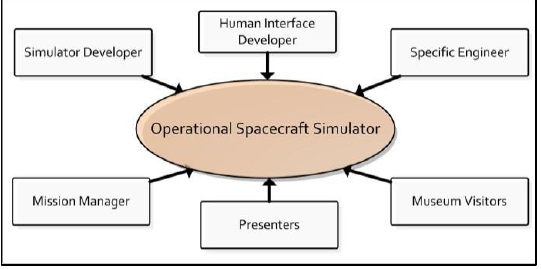
Fig. 3. Stakeholders diagram for an operational spacecraft simulator.